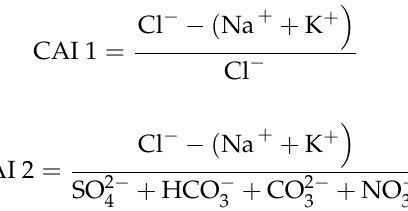
Figure 6. Mechanism controlling groundwater chemistry.